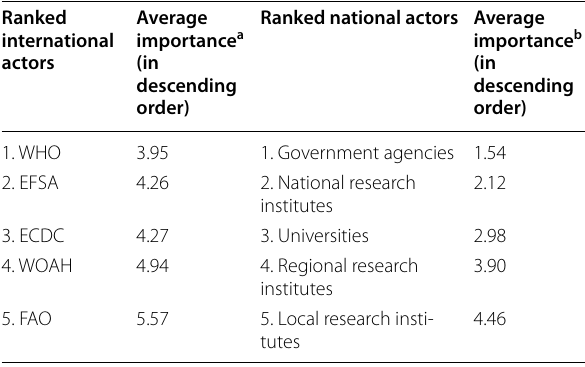
Table 4 Respondents’ ranking of importance of international and national